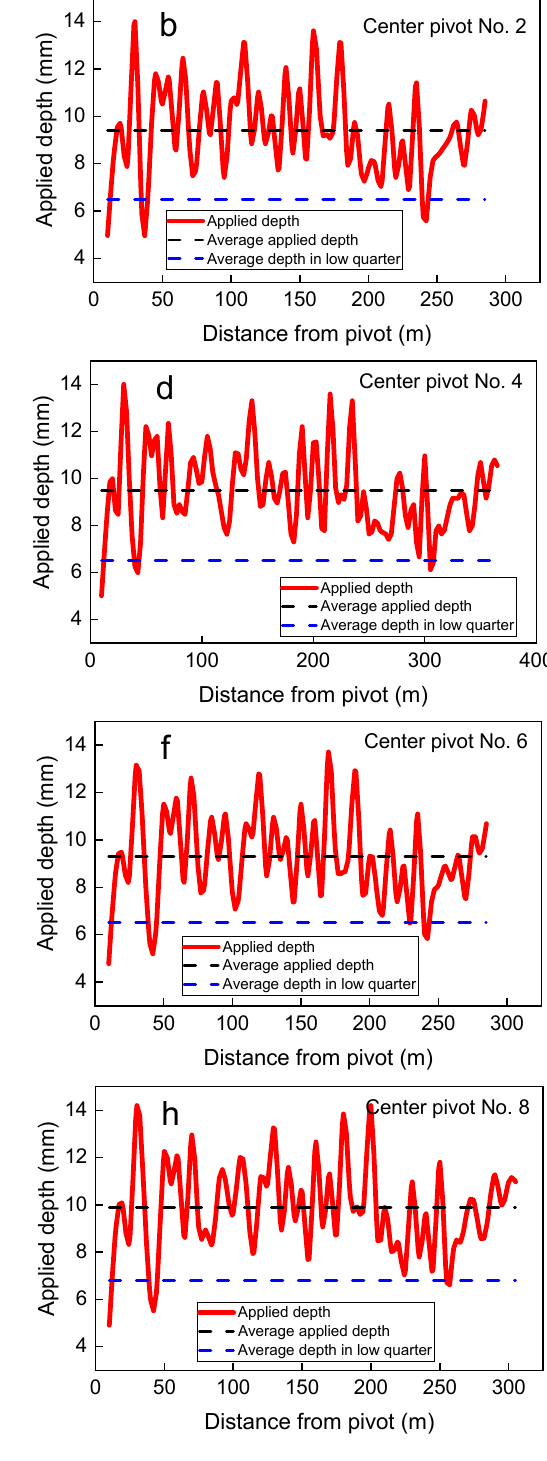
Figure 6. Water distribution patterns with the average depths and the average low quarter depths of application measured from the tested center pivot irrigation systems with standard laterals. The symbols ( a – h ) correspond to the tested center pivot systems numbered 1 to 8.